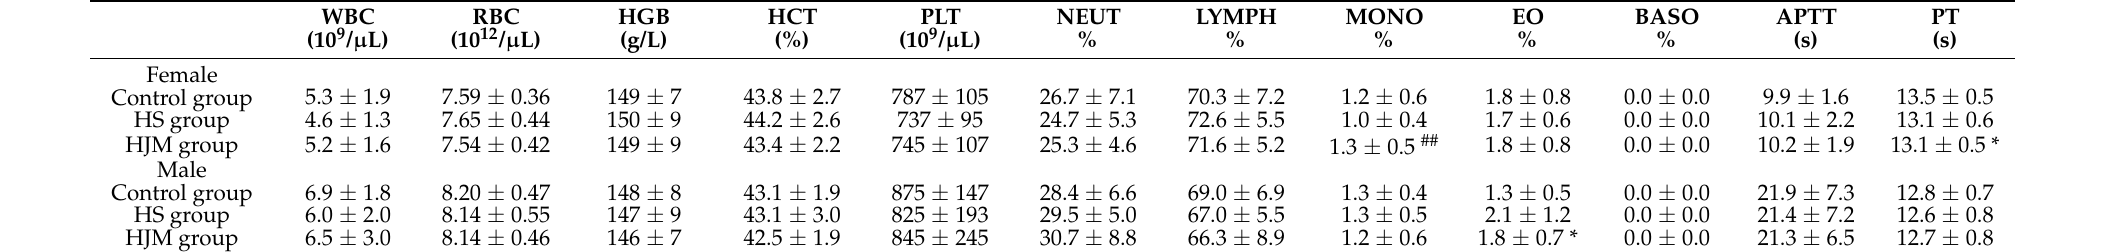
Table 3. Hematology parameters of male and female rats (mean ±